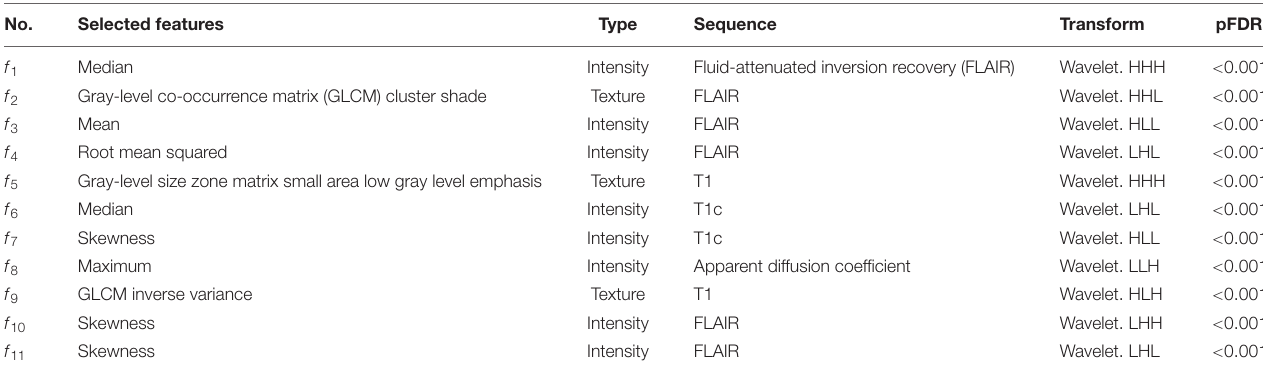
TABLE 2 | Eleven selected radiomics features for predicting the molecular subgroups of medulloblastoma patients.